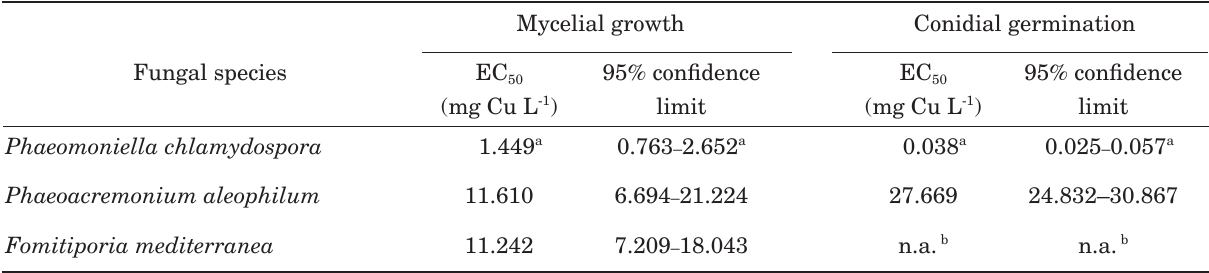
Table 3. Effectiveness of the copper formulation against the mycelial growth and conidial germination of species in the esca complex fungi.